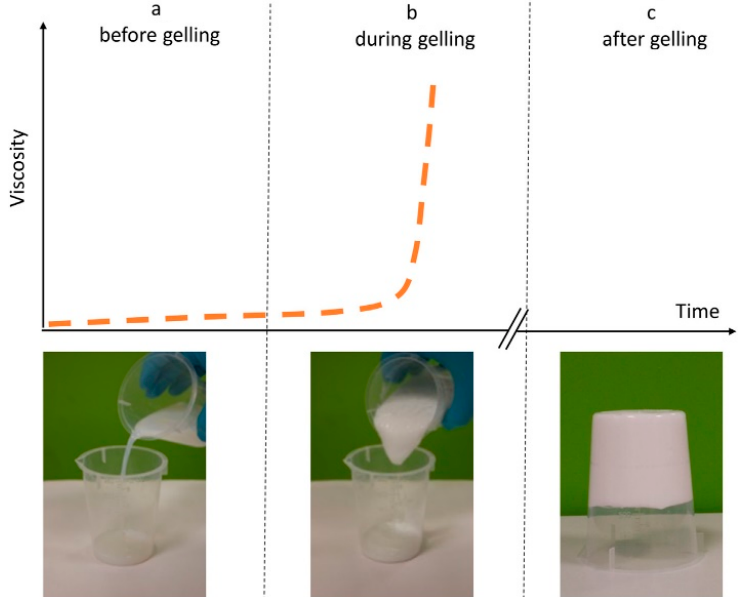
Figure 10. Gelation process of colloidal silica [11].